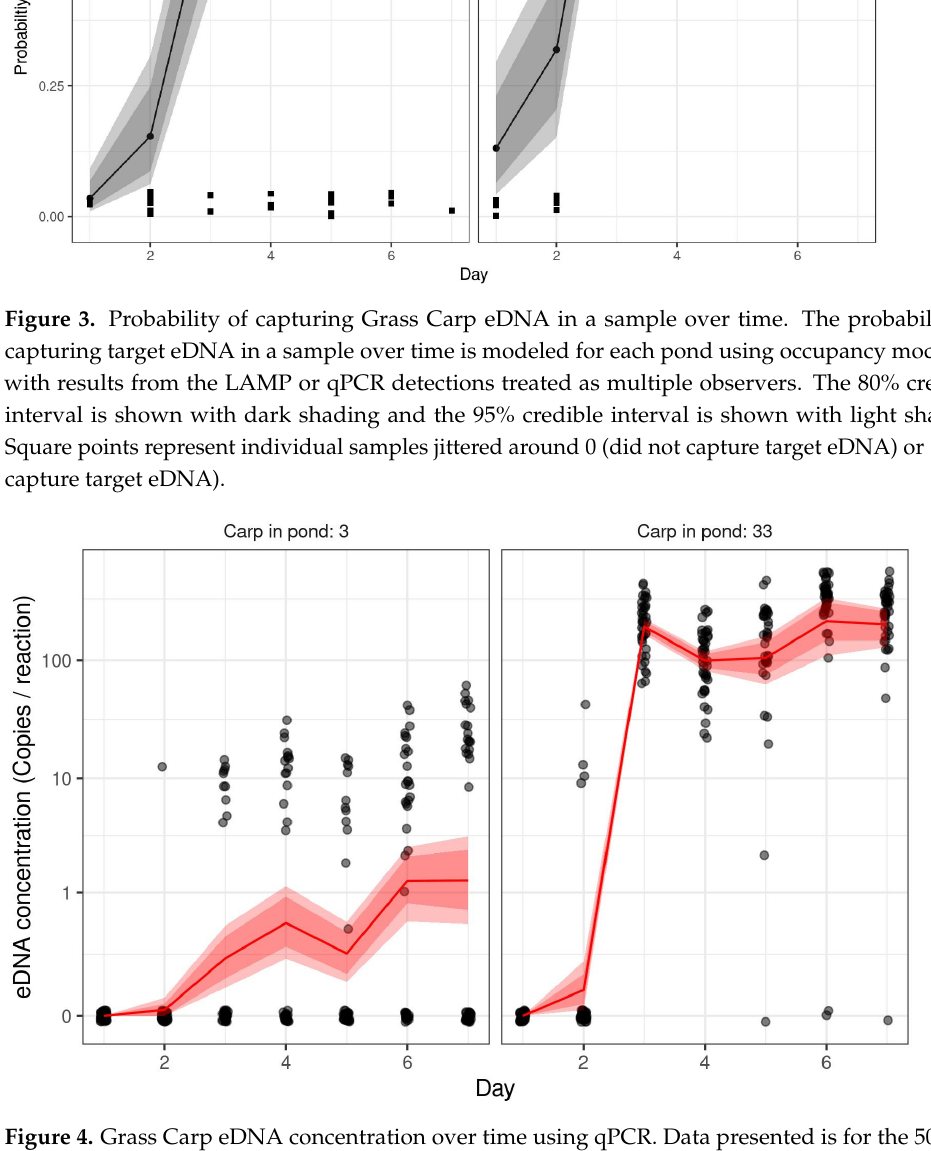
Figure 4. Grass Carp eDNA concentration over time using qPCR. Data presented is for the 500 mL samples. The 80% credible intervals are shown with dark shading and the 95% credible intervals are shown with light shading. Round points represent individual samples jittered around eDNA concentration in copies per reaction. Measurements above the 201 copies/reaction LOQ should be considered as accurate, and measurements below the LOQ should be considered as best available estimates. Values reported as 0 copies/reaction should be considered as likely negative but possibly containing target eDNA below the 7 copies/reaction LOD.